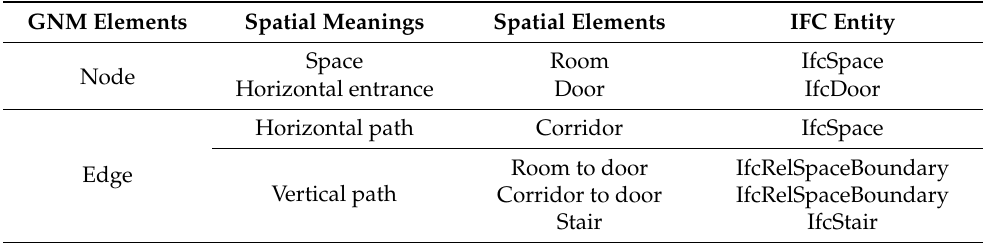
Table 2. Indoor elements for GNM.